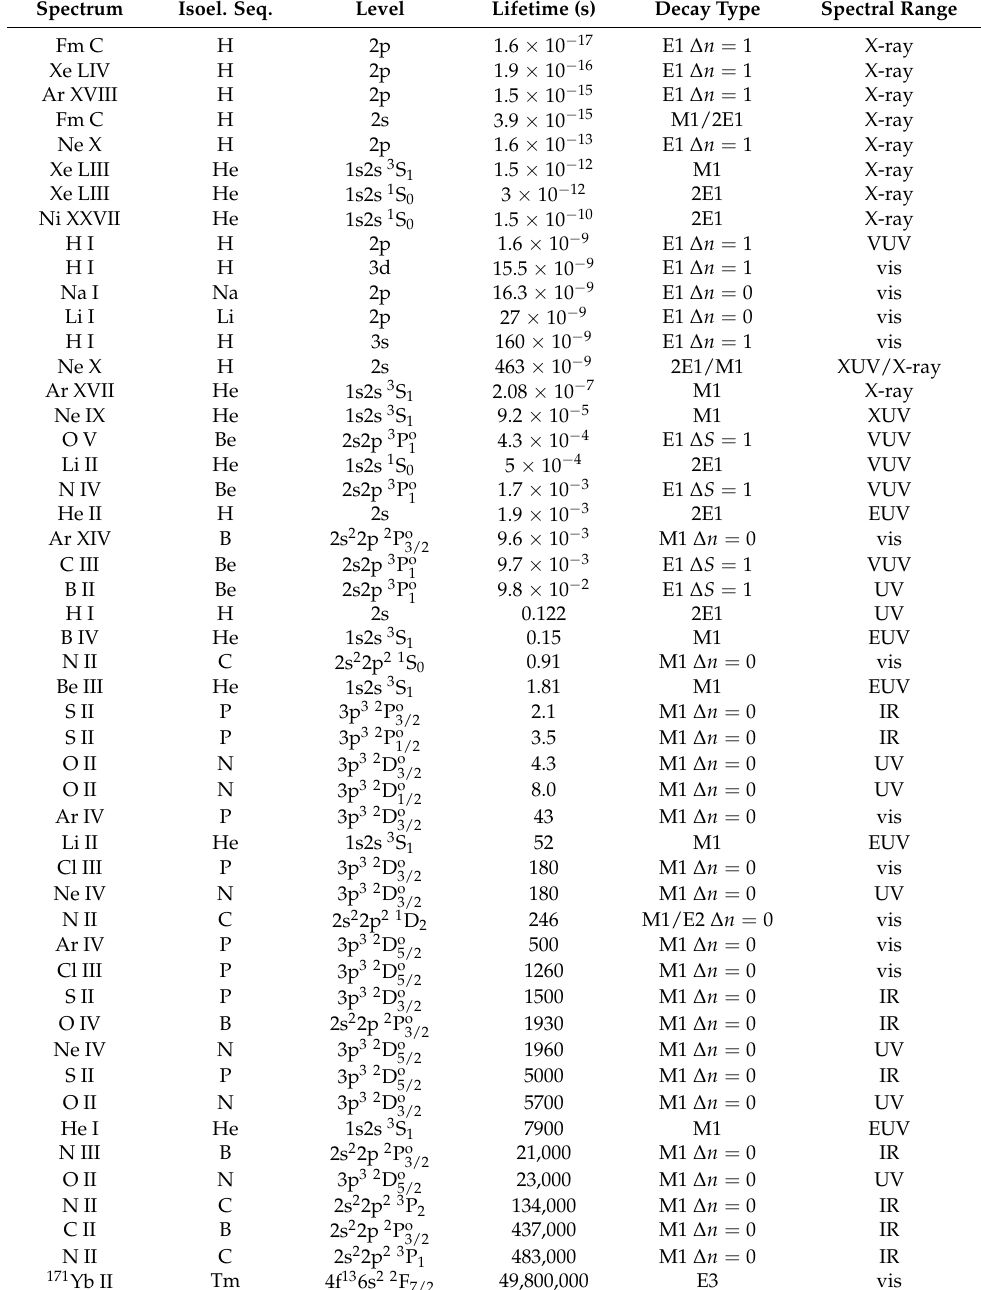
Table 1. Approximate level lifetimes and major decay channels of sample